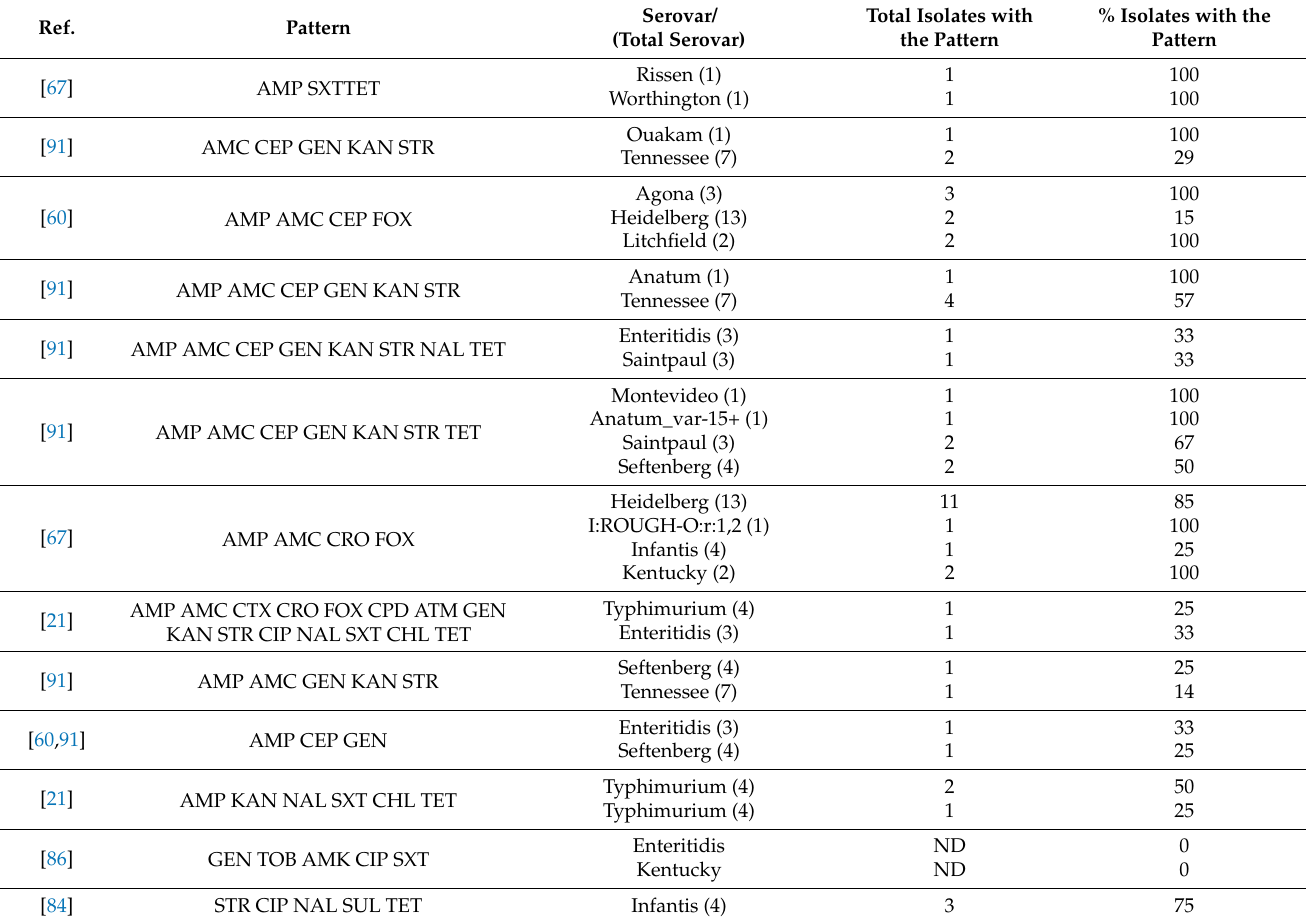
Table 3. Patterns of multidrug resistant Salmonella spp. as determined by MIC.